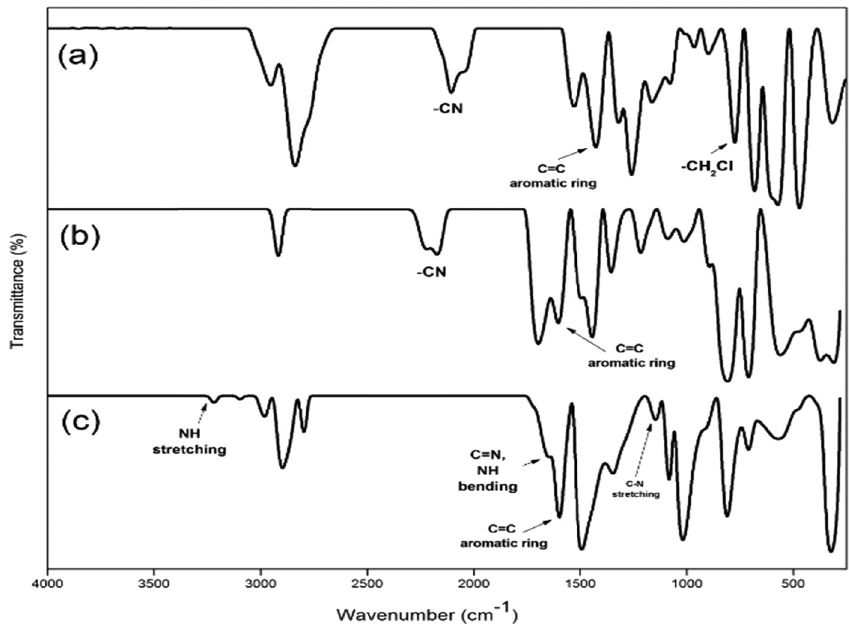
Figure 1: FT - IR spectra of ( a ) P1, ( b ) HXL P1, and ( c ) EDA - HXL P1,